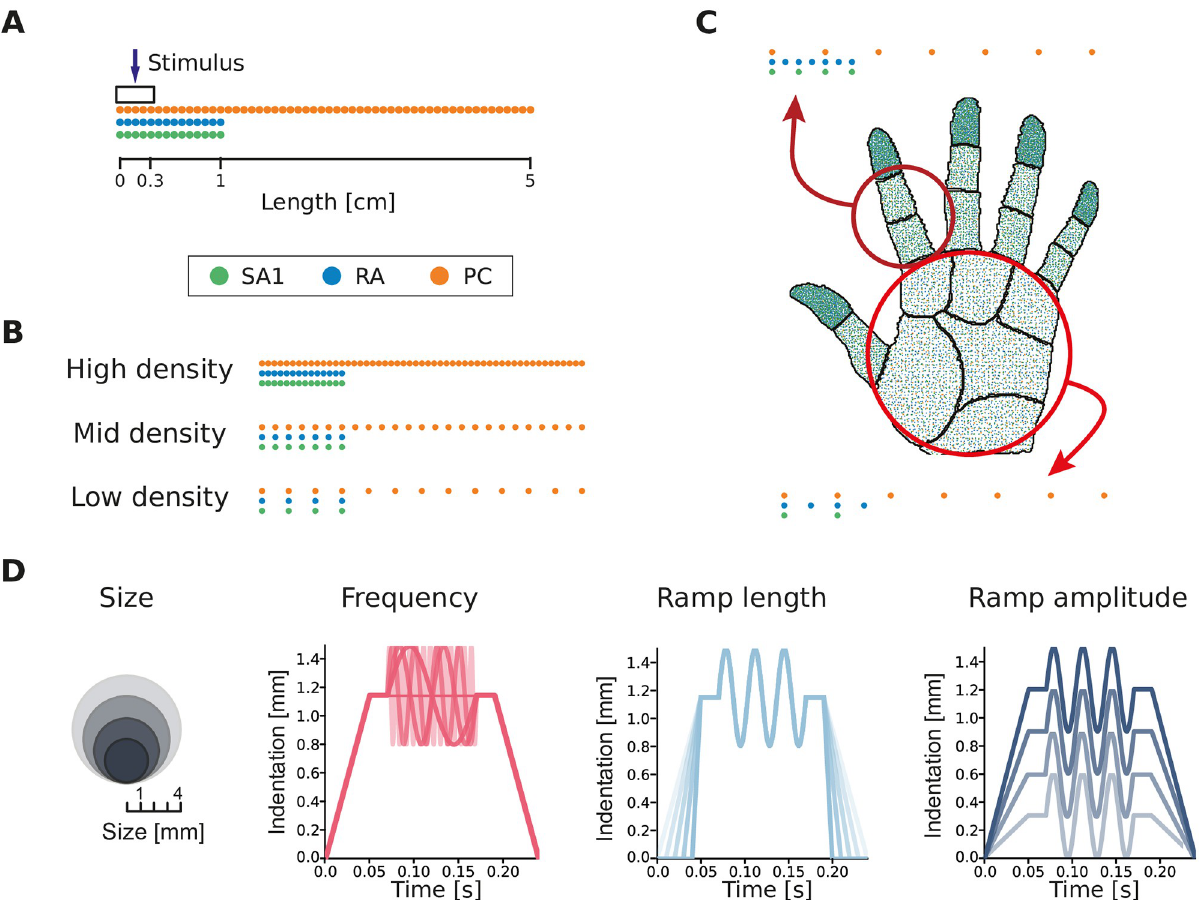
Fig 1. Simulation setup. (A) Example of afferents terminating along a line, radiating outwards from the probe center (indicated by the arrow). The probe has circular shape (of varying size) and is centered on the origin of the line. Dots of different colors correspond to different afferent classes (separated in the illustration to facilitate visualization). (B) Example of afferent populations with different densities. (C) Representation of afferent densities measured on the human hand and corresponding simulated populations distributed over a line that mimic the densities observed in the palm and finger. (D) Illustration of the different stimulus features considered: probe size, vibration frequency, ramp length, and ramp amplitude.